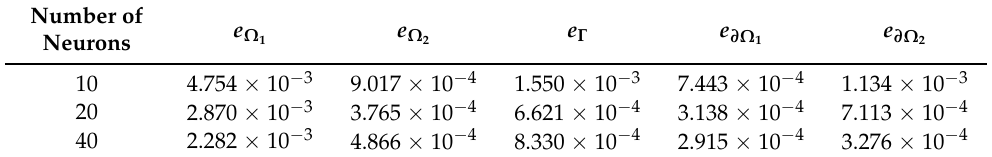
Table 6. Comparison of errors in different terms with different numbers of neurons for Example 3. Number